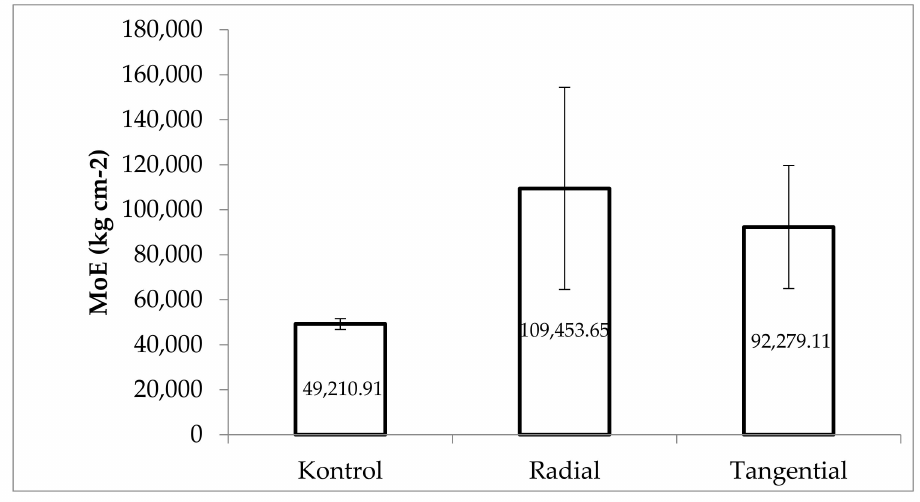
Figure 4. MOE of densified Pinewood on The Radial Board and The Tangential